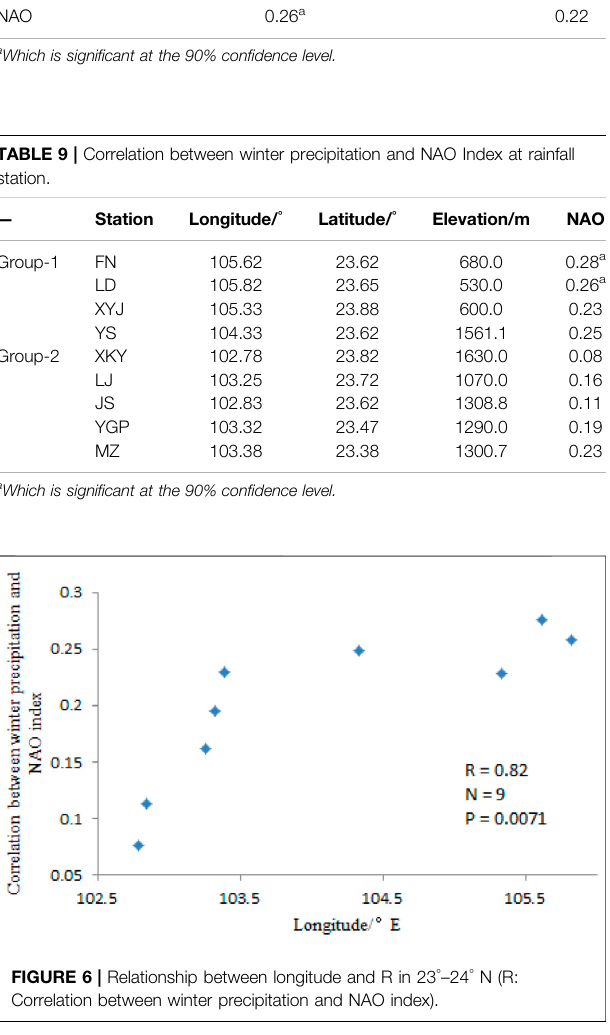
TABLE 8 | Correlation between winter precipitation and NAO Index in different regions. — Group-1 Group-2 NAO